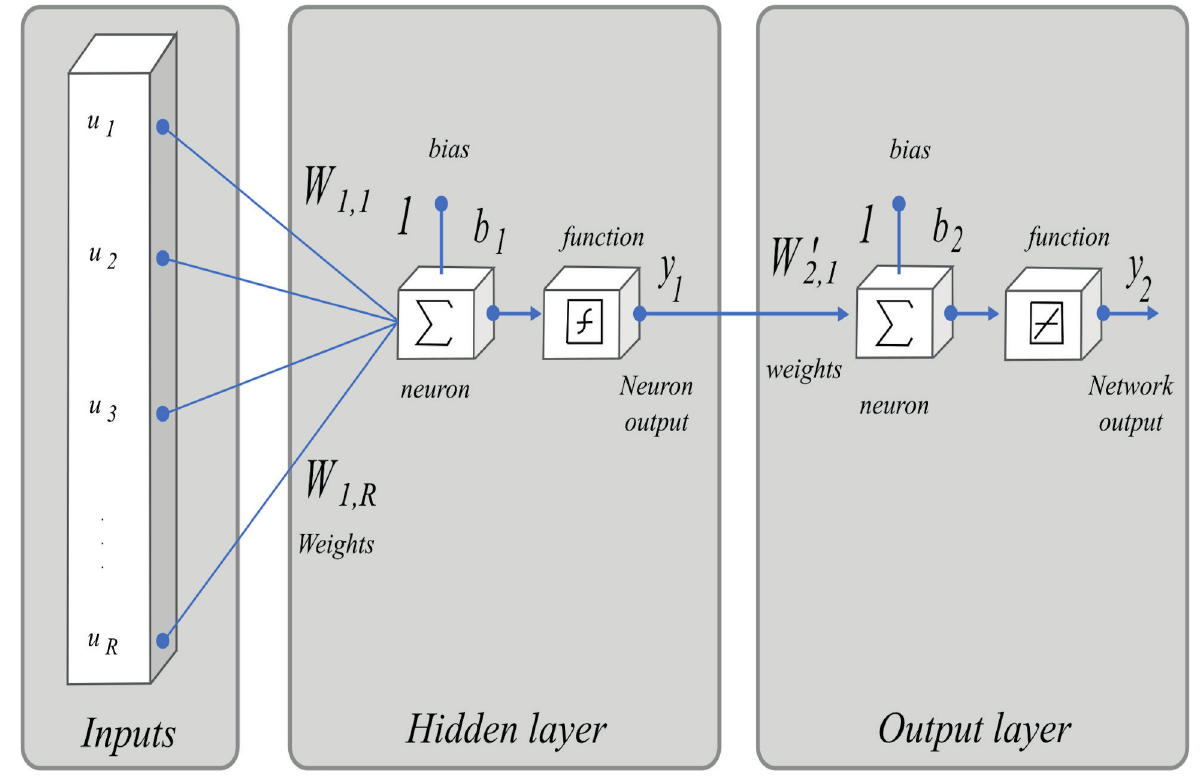
Figure 3 - Feedforward ANN